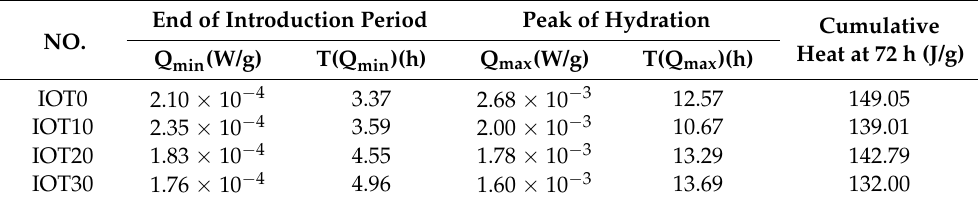
Table 4. Isothermal calorimetry test results of designed UHPC with IOT.